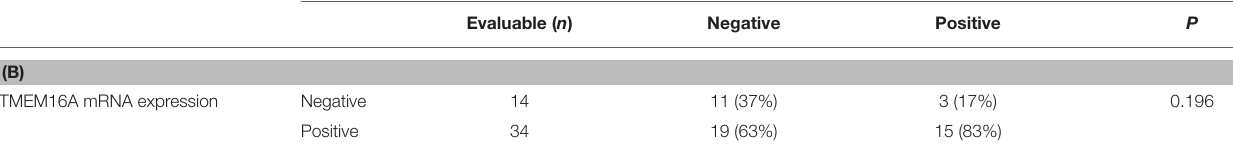
FIGURE 2 | mRNA expression in different lymph node status of colorectal carcinoma progression (* P < 0.05). (C) Positive rates of TMEM16A protein expression and mRNA expression in different stages of colorectal carcinoma progression (* P < 0.05). (D) Kaplan-Meier survival curve analysis showed that CRC patients with TMEM16A mRNA expression tended to a worse overall survival. (E) Kaplan-Meier survival curve analysis about effect of TMEM16A protein expression on patient verall survival. (F) The effect of TMEM16A mRNA expression on disease-free survival was analyzed by Kaplan Meier survival curve. (G) The effect of TMEM16A protein expression on disease-free survival was analyzed by Kaplan Meier survival curve.